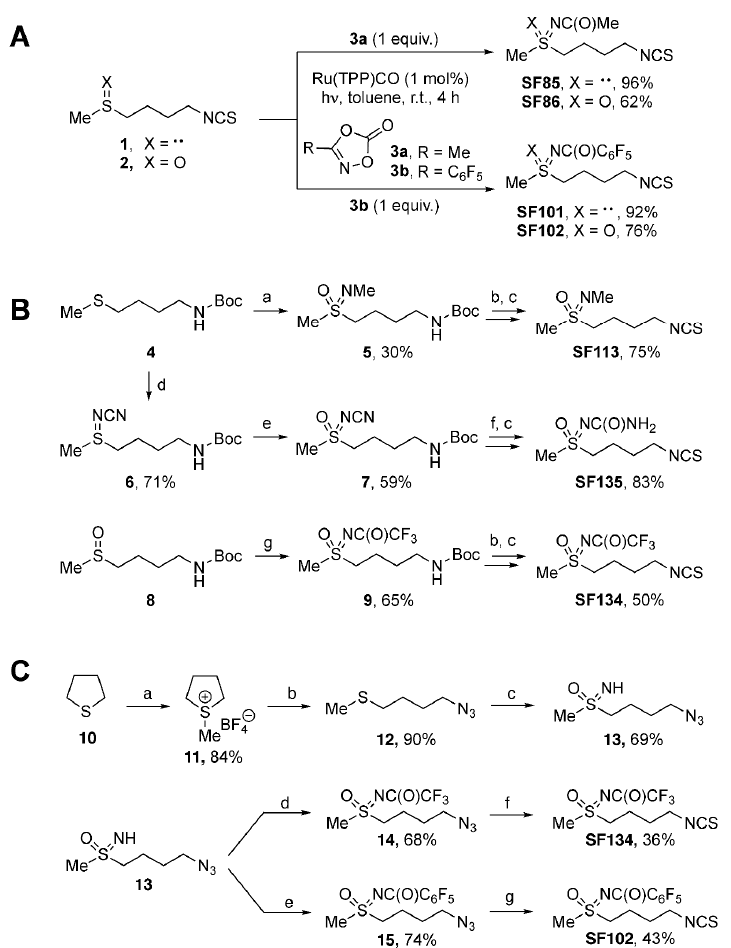
Figure 1. Scheme of chemical synthesis of sulforaphane derivatives. ( A ) Imidations of erucin (1) and sulforaphane (2) by light-induced ruthenium catalysis leading to the respective sulforaphane analogues SF85 , SF86 , SF101 , and SF102 . ( B ) Syntheses of sulforaphane analogues SF113 , SF135 , and SF134 . Procedures: (a) 1. MeNH 2 (3.0 equiv.); Br 2 (2.0 equiv.), MeOH, r.t. 20 min.; 2. KMnO